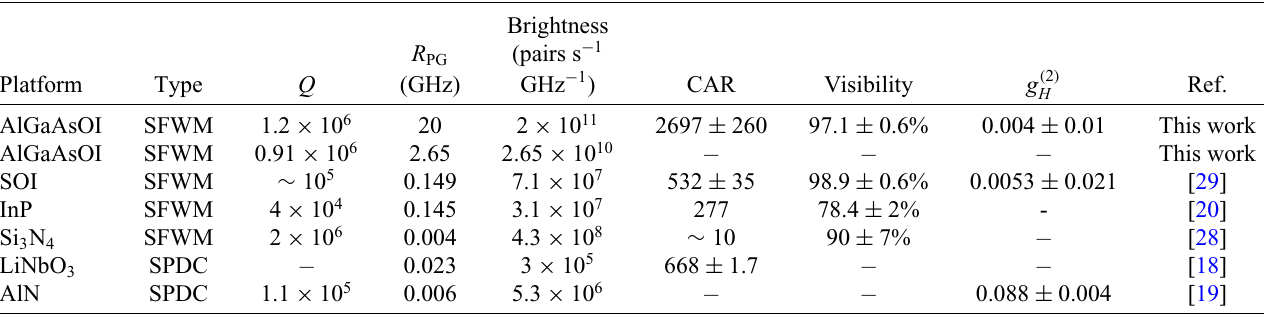
TABLE I. All values are reported for microring resonators except for LiNbO 3 , which is acquired from a linear waveguide. The CAR, ( 0 ) are shown for 1-MHz R visibility, and g ( 2 ) PG . The brightness and R PG are shown normalized to a 1-mW on-chip pump power. H